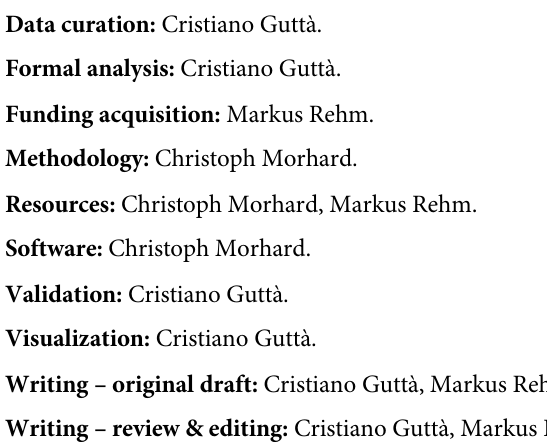
S2 Table. Accuracy, sensitivity, specificity and Log-rank P value of each CV iteration and pooled category predictions for the experimental settings displayed in Figs 3 and S3. S3 Table. Accuracy, sensitivity, specificity and Log-rank P value of each CV iteration and pooled category predictions for the experimental settings displayed in S4, S6B, S6C Figs. S4 Table. Accuracy, sensitivity, specificity and Log-rank P value of each CV iteration and pooled category predictions for the experimental settings displayed in S5, S6D, S6E Figs. S5 Table. Accuracy, sensitivity, specificity and Log-rank P value of each CV iteration and pooled category predictions for the experimental settings displayed in Figs 5 and